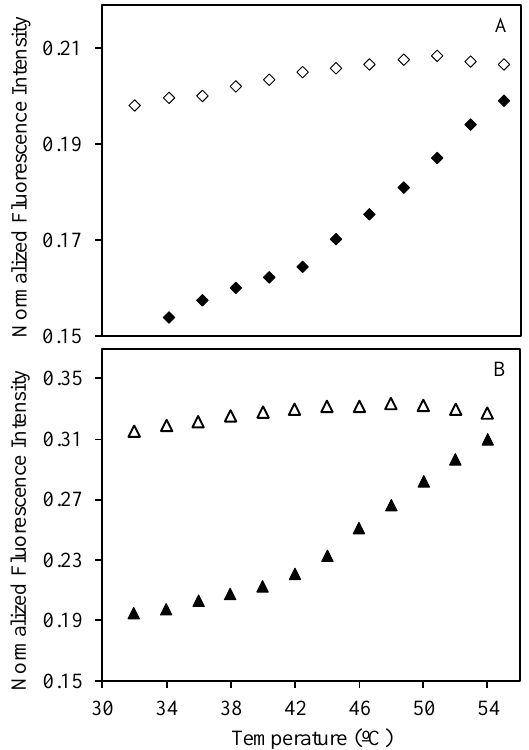
Figure 7. Fluorescence intensity of ( A ) 1:1 and ( B ) 4:1 SRP:DNA-ROX mixtures, measured at 610 nm for temperatures between 32 and 54 °C, normalized for the change in ROX quantum yield with temperature. The heating and cooling cycles are represented by full and empty symbols, respectively.